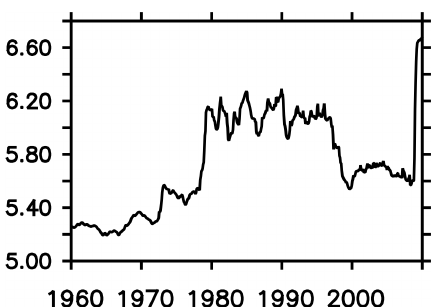
Figure 14. Observational estimate of annual mean sea surface tem- peratures south of 40 ◦ S calculated from HadISST (Rayner et al.,